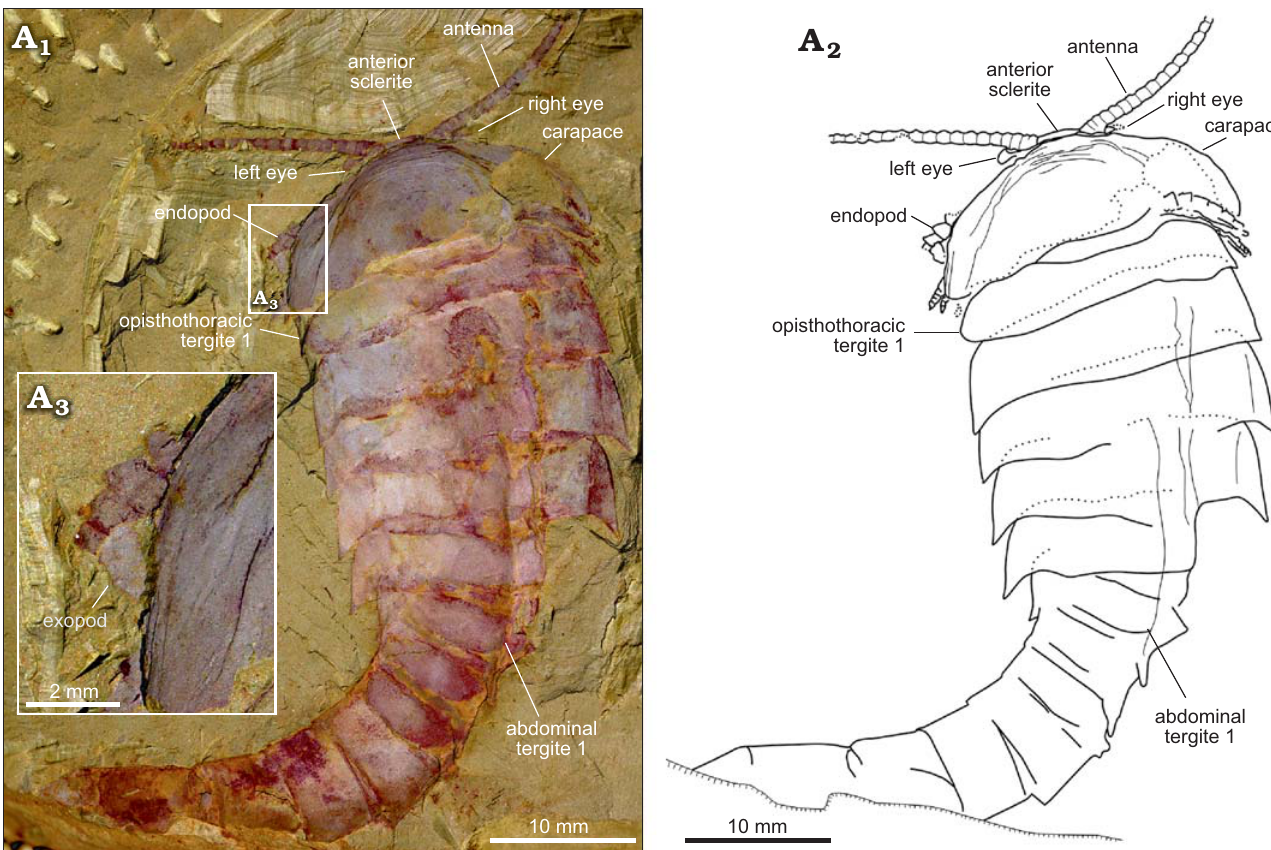
Fig. 3. An almost complete and exquisite specimen of fuxianhuiid arthropod Guangweicaris spinatus Luo, Fu, and Hu, 2007 (YKLP 11141) from the lower Cambrian Guanshan Biota, China. Specimen in dorsal view showing the antennae, eyes, carapace and trunk (A 1 ), explanatory drawing (A 2 ), close-up of the left margin of the carapace, showing the flap of an exopod (A 3